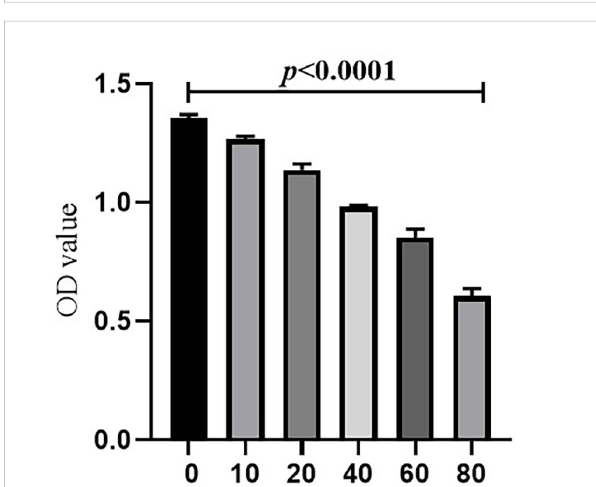
FIGURE 5 The anti-C1qA08 antibody inhibited the binding of C1q to mCRP. The addition of different concentrations of C1qA08 antibody, as shown by the graph could inhibit the binding of mCRP to C1q, and when 80 m g/ml anti-C1qA08 antibody was added, the inhibition rate exceeded